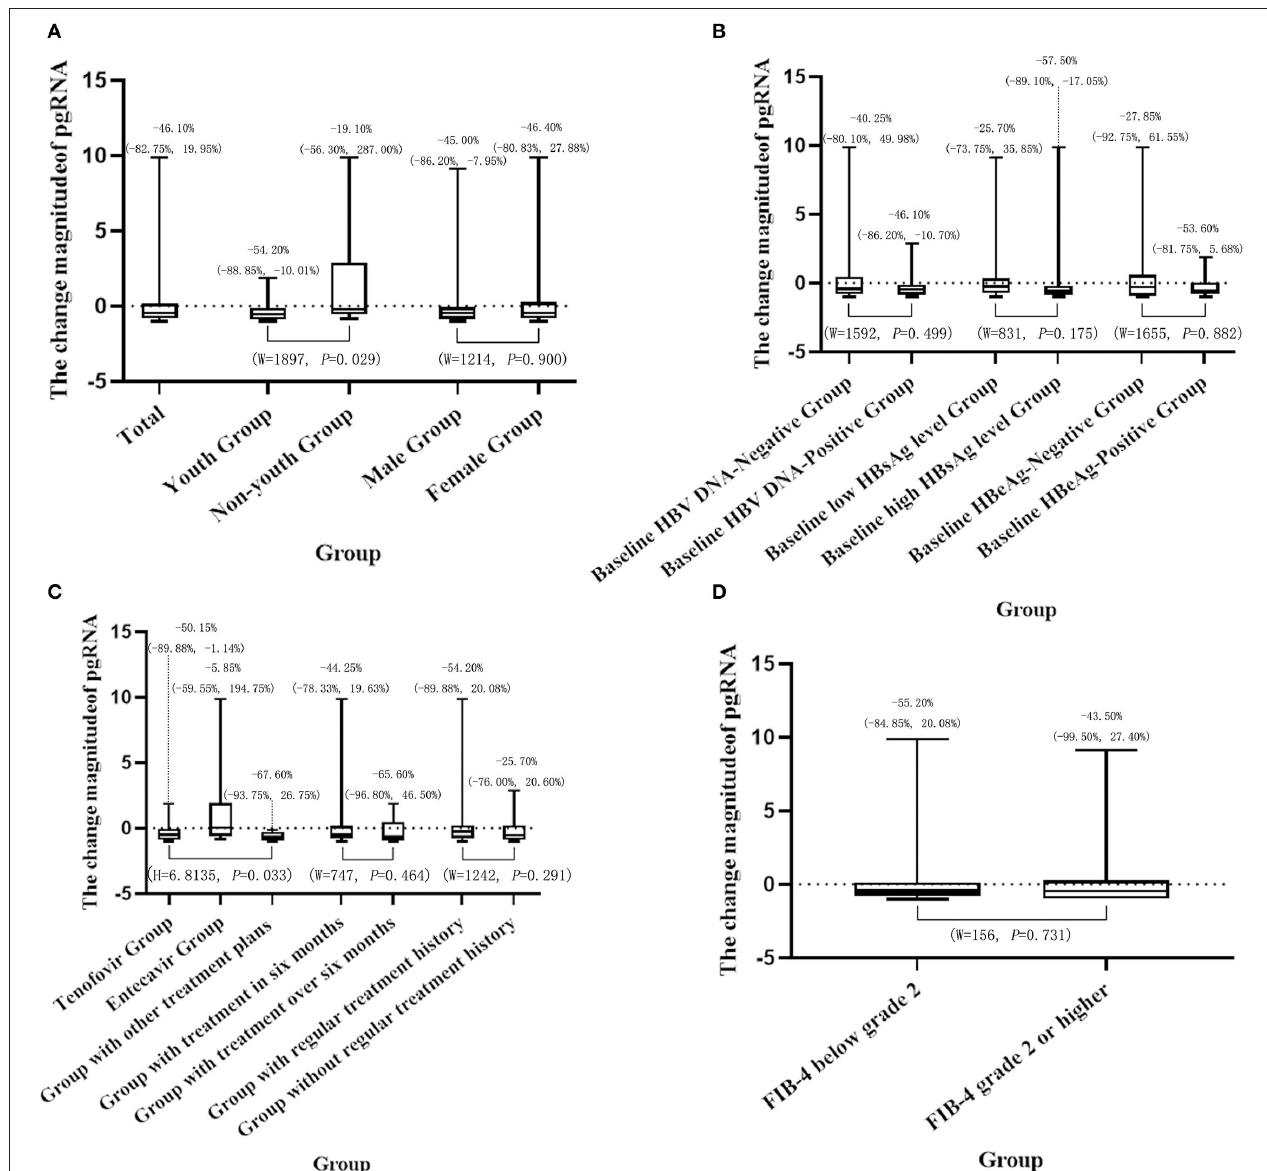
Table 1 ). Number of patients with FIB-4 below grade 2, grade